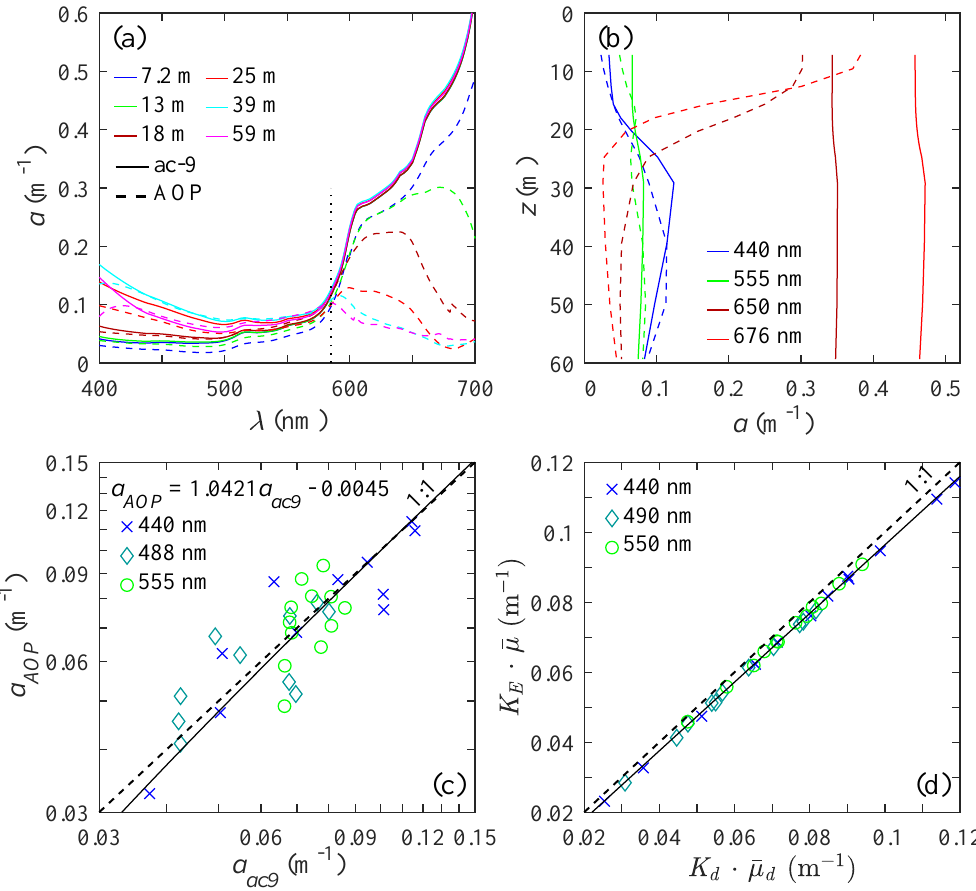
Figure 14. Comparison of the absorption coefficient of seawater measured with an ac-9 instrument ( a ac9 ) and estimated from AOPs using the irradiance quartet measurements and Gershun’s equation ( a AOP ). ( a ) Spectra of absorption coefficient at depths for which the determinations of K E were made on the basis of radiometric measurements taken at one station in the Carmen Basin where ac-9 measurements were made during the 2011 cruise. The vertical dotted line indicates the transition region to long-wavelength portion of the spectrum where the use of Gershun’s is inadequate because of the effects of inelastic processes. ( b ) Vertical profiles of absorption coefficient measured with the ac-9 instrument (solid lines) and estimated from AOPs (dashed lines) at selected light wavelengths as indicated. Data were collected at the same station as in panel ( a ). ( c ) Direct comparison between a AOP and a ac9 at selected blue and green spectral bands as indicated. Data were collected at one station in the Guaymas Basin and one station in the Carmen Basin where ac-9 measurements were made during the 2011 cruise. ( d ) Relationship between K E · µ and K d · µ for the blue-green spectral regions based on data at the three d selected light wavelengths as indicated. Solid lines in ( c , d ) represent the best-fit regression functions and dashed lines the 1:1 agreement between the